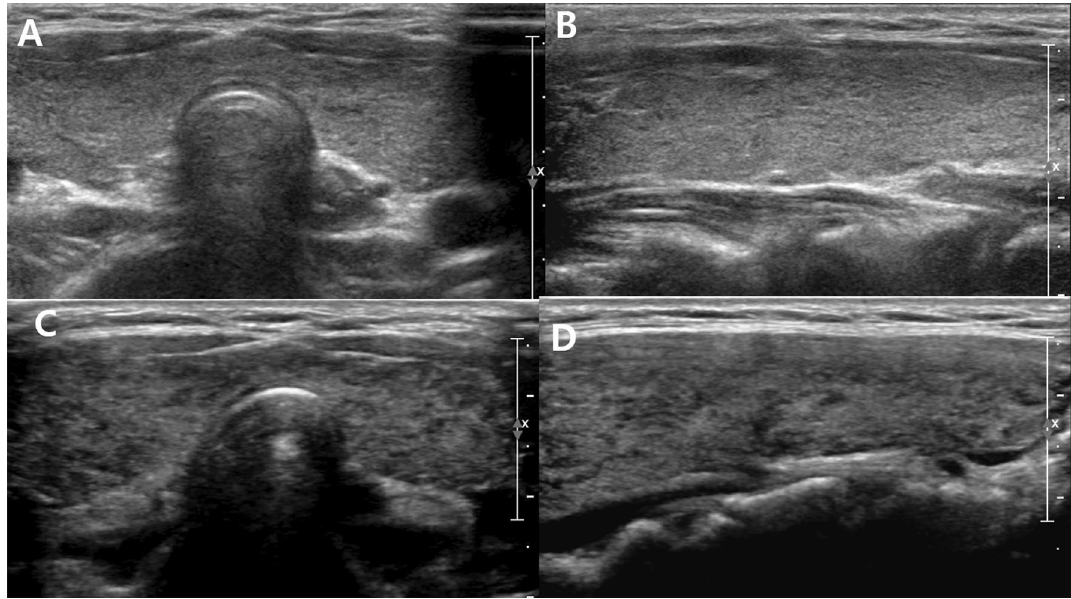
Figure 8. A 16-year-old female patient: initial US ( A and B ) was classified as G2. On follow-up US after two years, hypoechogenicity and heterogeneity were aggravated and classified as G4 ( C and D ). Simultaneously, TFT results were also aggravated (euthyroidism to overt hyperthyroidism).